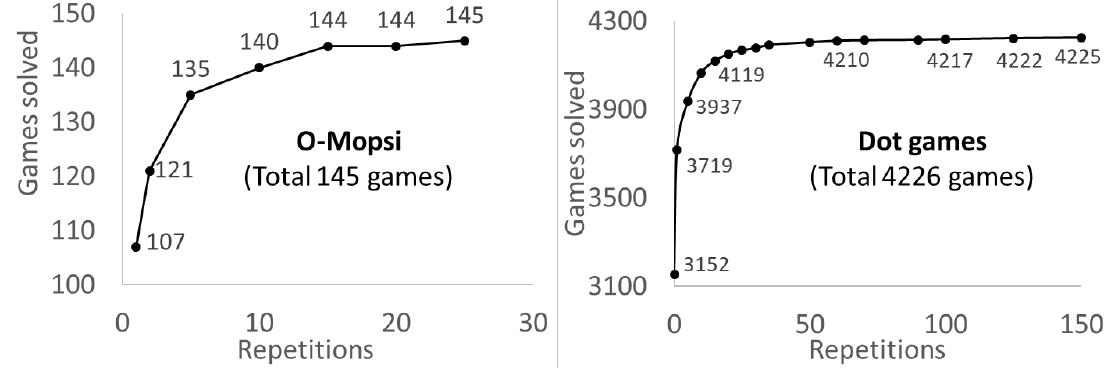
Figure 15. Instances solved as a function of the number of repetitions.